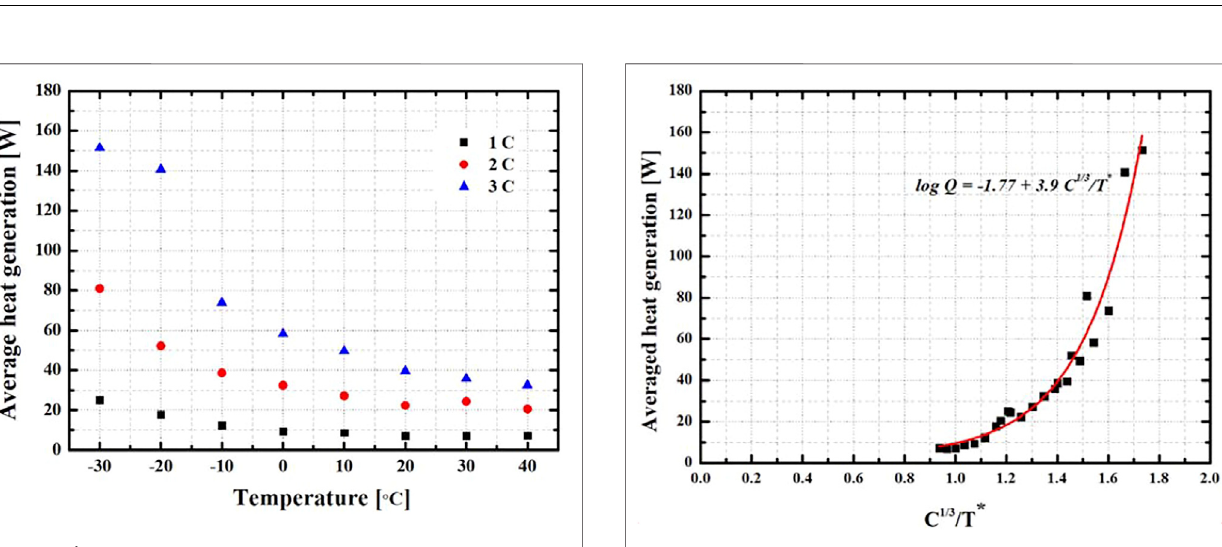
FIGURE 6 | The resulting heat generation versus. C 1 / 3